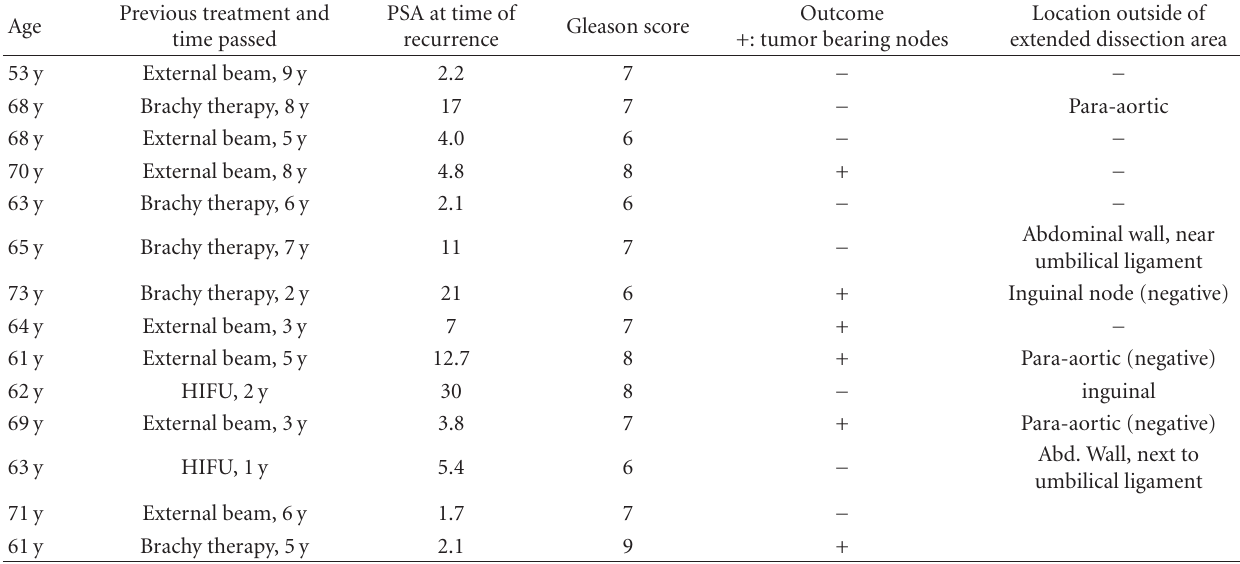
Table 2: Characteristics of 14 patients with a recurrence in the prostate and the outcome of the SN procedure. None of the nodes outside the extended dissection area was tumor